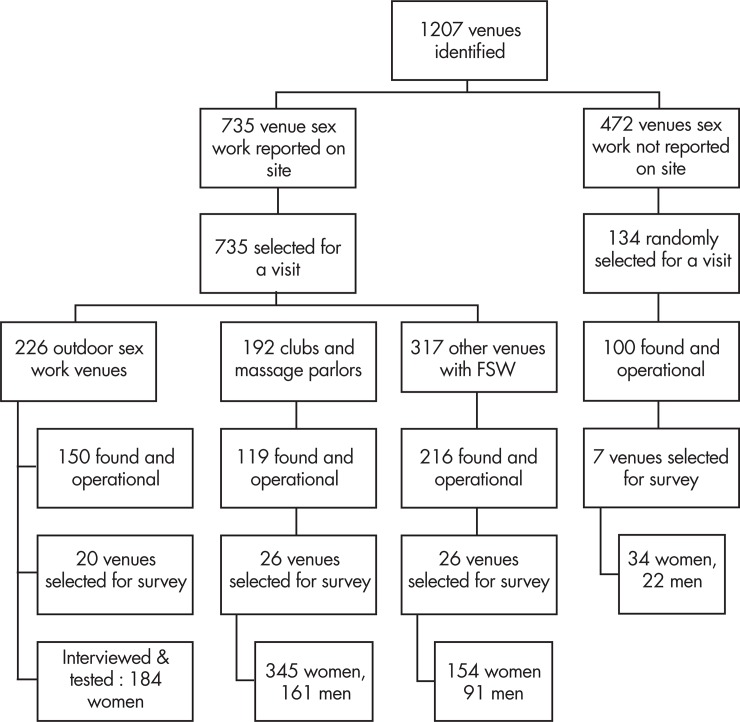
Sampling flow chart by venue group and sample size.